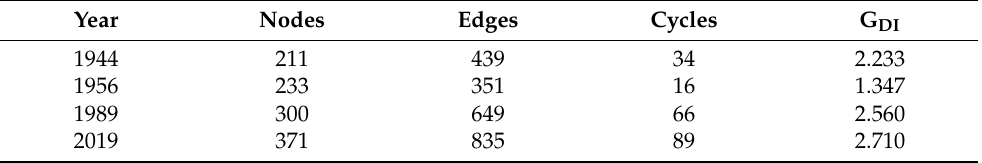
Table 2. Changes in the degree of development of graphs of W˛egorzewo during the studied periods. Year Nodes Edges